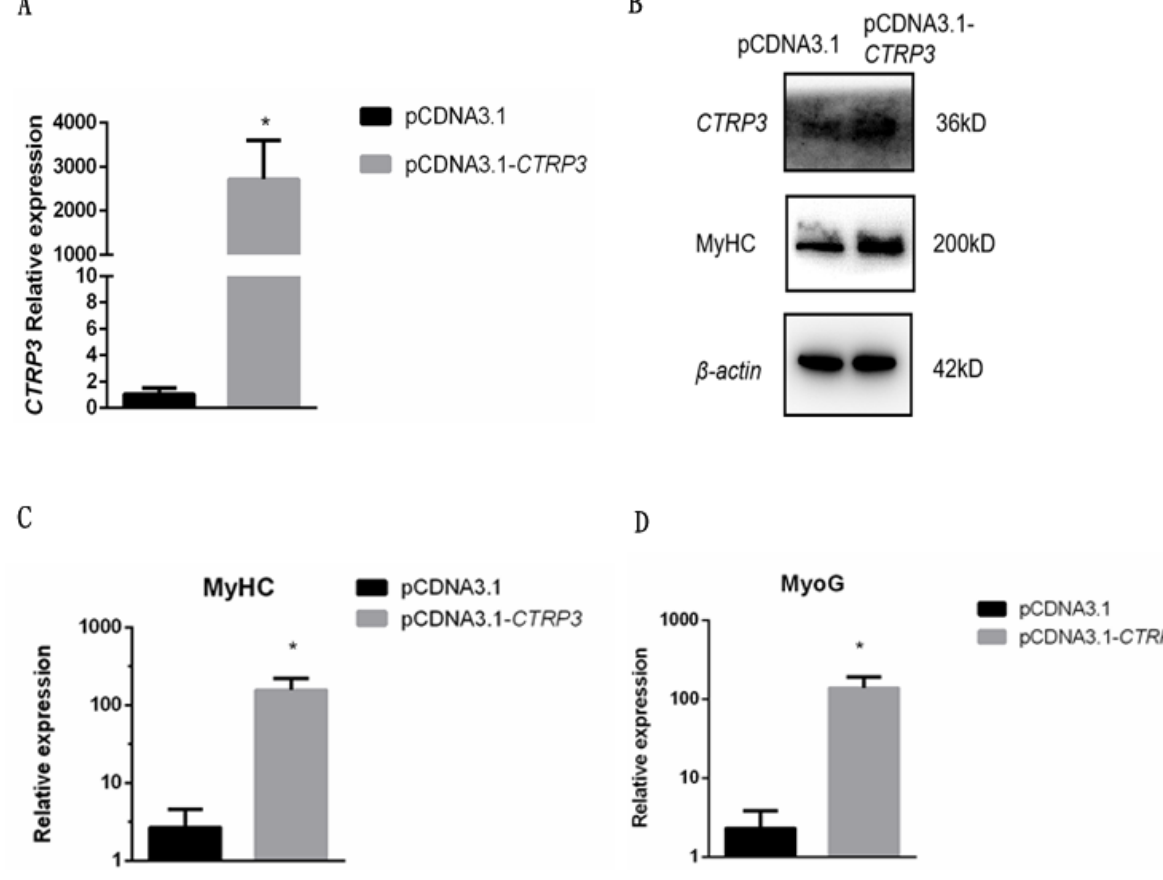
Figure 5. Overexpression of CTRP3 promoted the expression of MyHC and MyoG during differentiation. (A) The mRNA level of CTRP3 was detected by qPCR in myoblast transfected with pCDNA3.1- CTRP3 or pCDNA3.1 at day 3 of DM. (B) The protein levels of CTRP3 and MyHC were detected by western blotting in myoblast transfected with pCDNA3.1-CTRP3 or pCDNA3.1 at day 3 of DM. (C) The mRNA level of MyHC was detected by qPCR in myoblast transfected with pCDNA3.1-CTRP3 or pCDNA3.1 at day 3 of DM. (D) The mRNA level of MyoG was detected by qPCR in myoblast transfected with pCDNA3.1-CTRP3 or pCDNA3.1 at day 3 of DM. Results are expressed as mean±standard error of the mean (n = 3). * p<0.05. CTRP3 , C1q and tumor necrosis factor-related protein 3; MyHC, myosin heavy chains; MyoG, myogenin; qPCR, quantitative polymerase chain re- action; NC, negative control; DM, differentiation Figure 6A, the mRNA level of Notch signaling pathway-re- lated genes, notch receptor 1 ( Notch1 ), notch receptor 2 ( Notch2 ), and hairy/enhancer-of-split related with YRPW motif 1 (Hey1), were significantly induced after transfecting with siRNA- CTRP3 in goose skeletal muscle satellite cell.